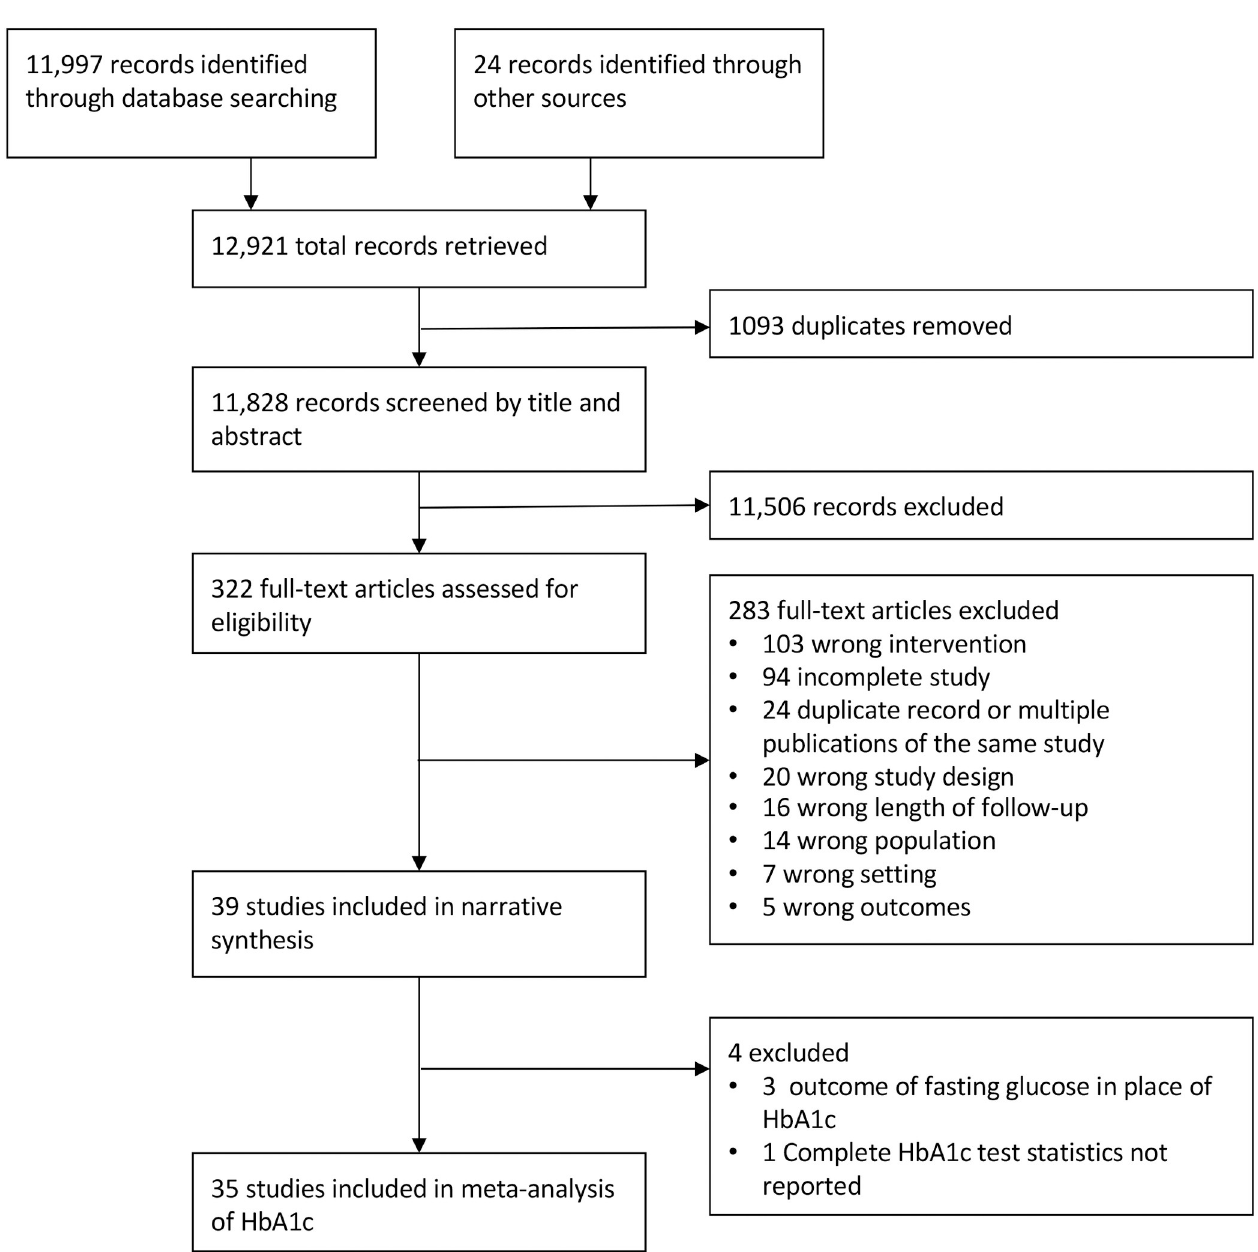
Fig 1. PRISMA study flow diagram. HbA1c, hemoglobin